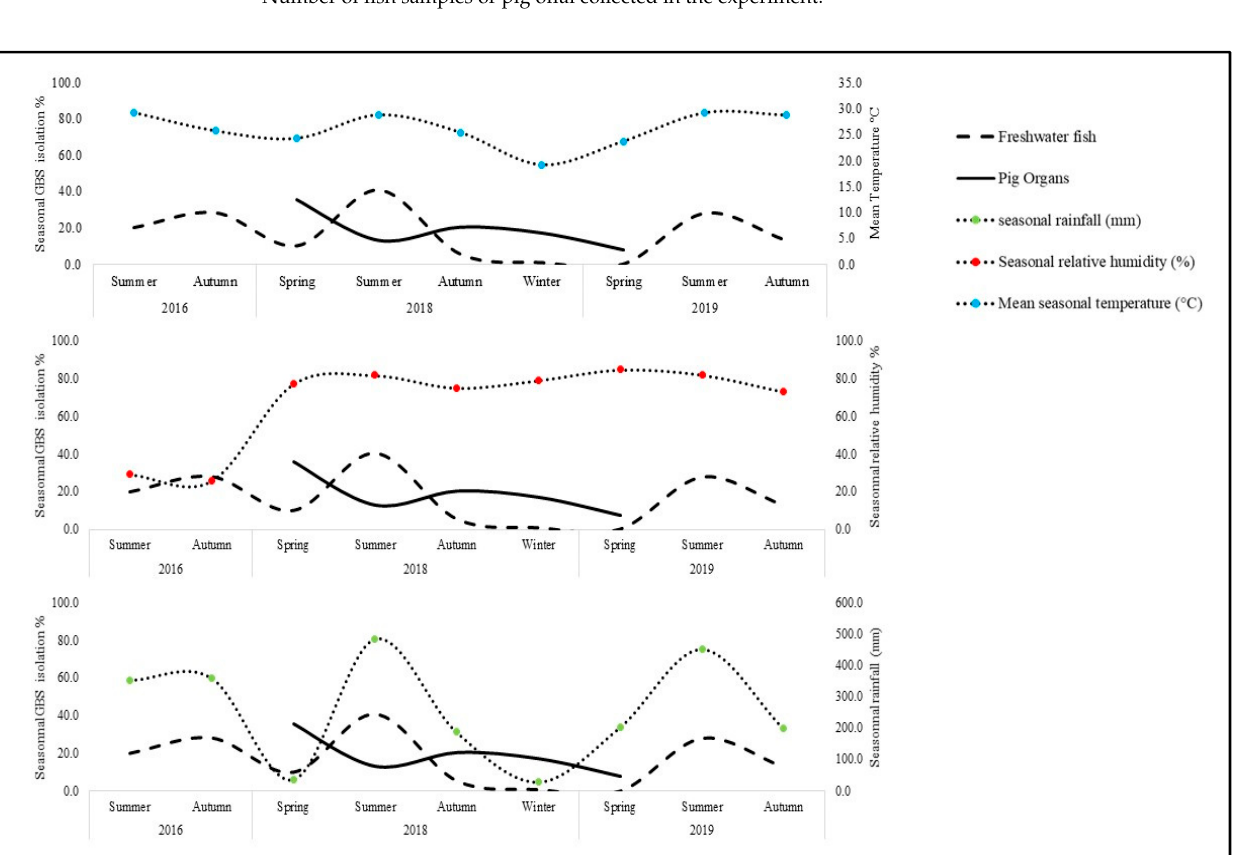
Figure 1. Association of climate and prevalence of GBS in fish and pig offal in Hong Kong. Percentage of GBS isolation among fish samples and pig organs in relation to ( A ) mean seasonal temperature, ( B ) seasonal relative humidity, and ( C ) seasonal rainfall is shown. The biofilm formation test showed that 78.5% (198/252) of GBS strains were biofilm formers. Over 71% (137/191) of fGBS and 98.4% (60/61) of pGBS were moderate biofilm formers, while one pGBS isolate was a strong biofilm former (Table S1). None of the fGBS strains were strong biofilm formers. However, 28% (54/191) of fGBS were weak or non-biofilm-forming (Figures S1 and S2). There was no significant difference in the biofilm